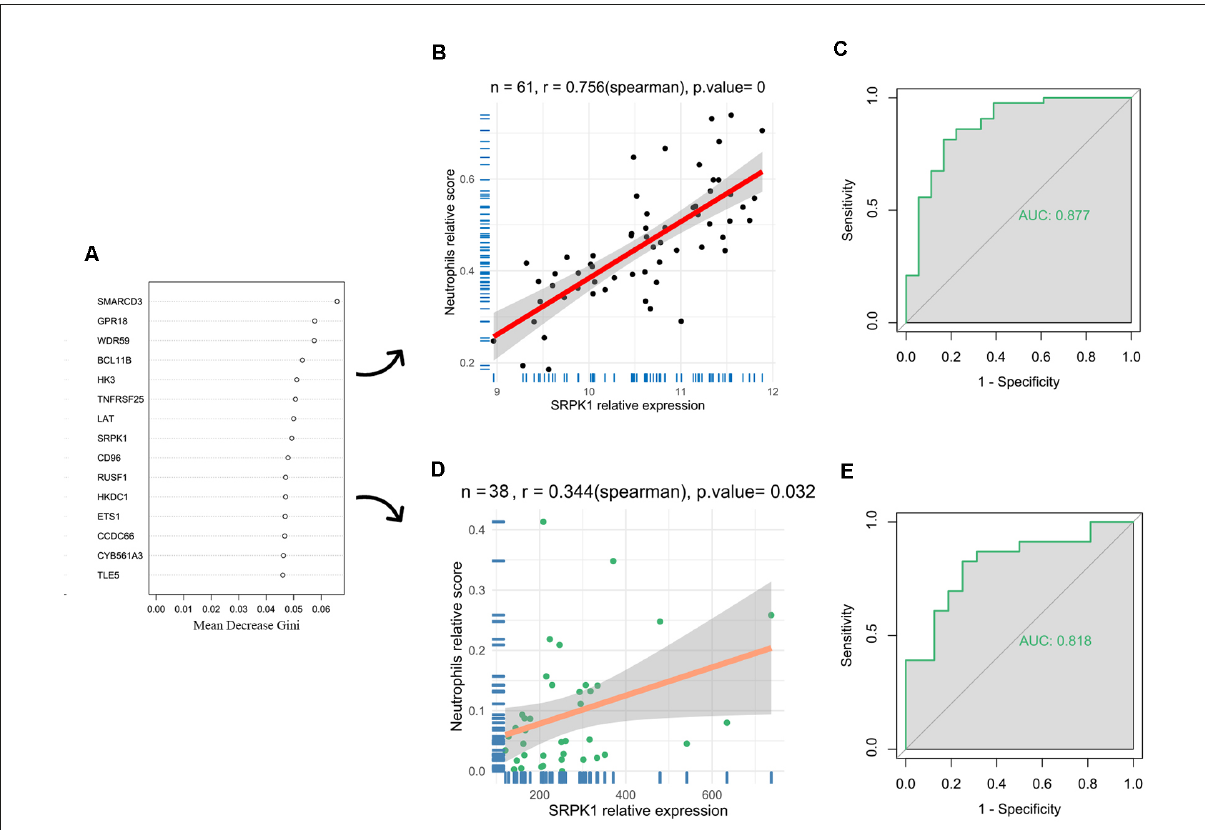
FIGURE4 Identification of key genes. (A) Results of random forest showing the top 15 genes. To select key genes correlated with above infiltrated immune situation. (B) The correlation coefficient between SRPK1 and neutrophils was 0.76 ( p < 0.001) in the blood sample dataset. (C) The area under the curve (AUC) was 0.877 (95% CI: 0.773–0.982). (D) The correlation coefficient between SRPK1 and neutrophils was 0.34 ( p = 0.032) in the arterial sample dataset. (E) The area under the curve (AUC) was 0.818 (95% CI: